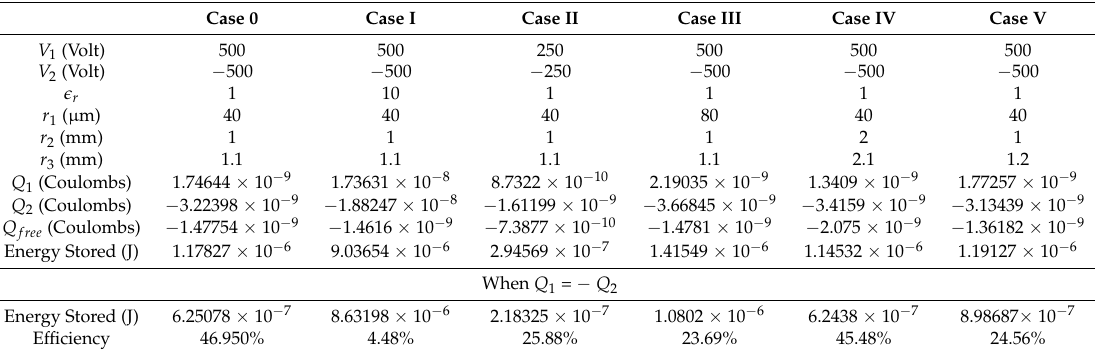
Figure 15. The electric field distribution of the proposed device when the thin metal sheet diameter is doubled. Table 2. The device performance